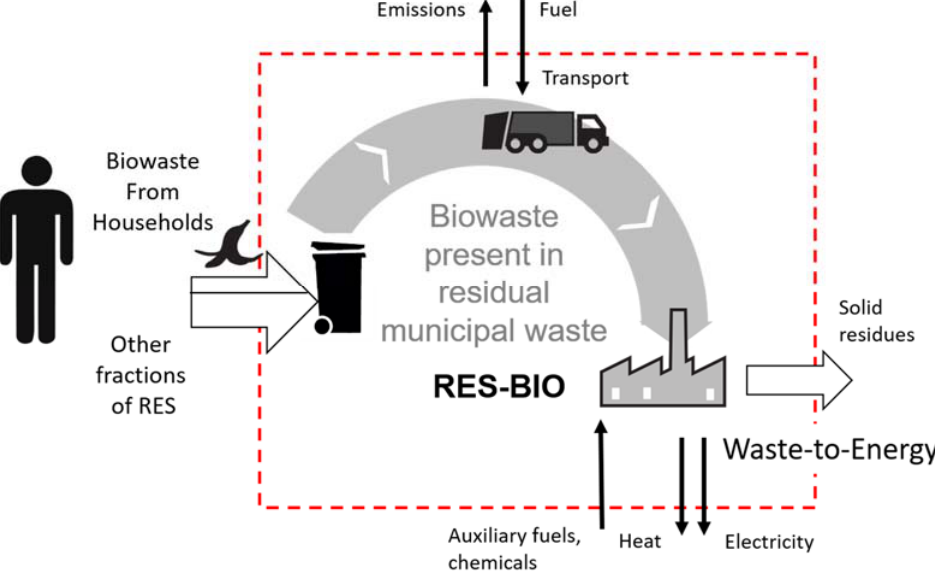
Figure 4. System boundaries for biowaste treated with other components of residual waste (RES-BIO) in WtE plants.